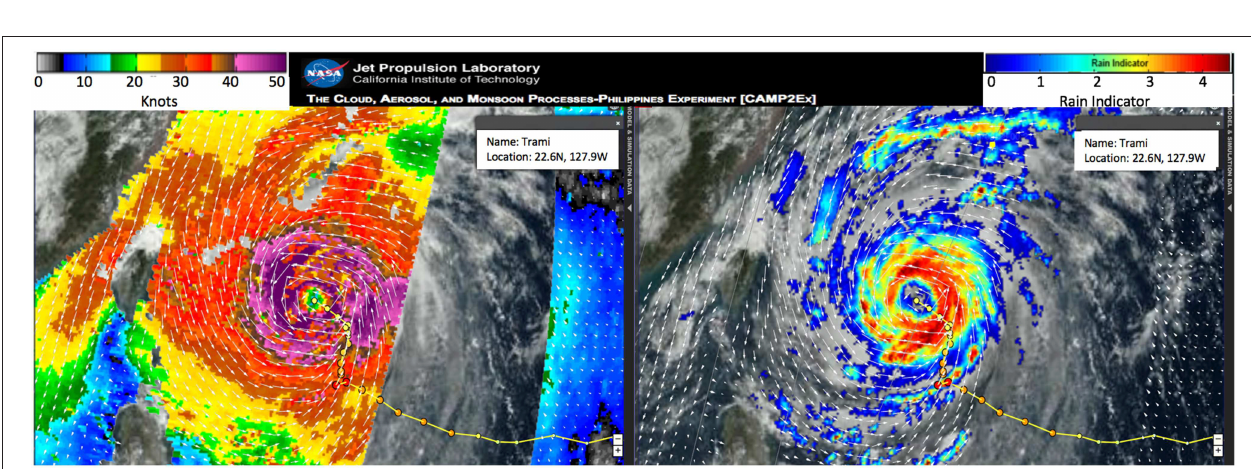
FIGURE 8 | Retrievals of the ocean surface winds from the Ku-band ScatSat-1 scatterometer as it flew over typhoon TRAMI on 28th September 2018 at 01Z (left). Almost coincident depiction of the precipitation structure as observed by the passive microwave radiometer GMI on the GPM-core satellite, overlaid with the wind vectors retrieved from Scat-Sat1 (right). The background in both panels shows the cloud field as depicted by the visible channels of the Himawari geostationary satellite. Such multi-parameter and multi-instrument data can be visualized interactively in the CAMP2Ex and the North Atlantic Hurricane Watch portals that are part of the JPL Tropical Cyclone Information